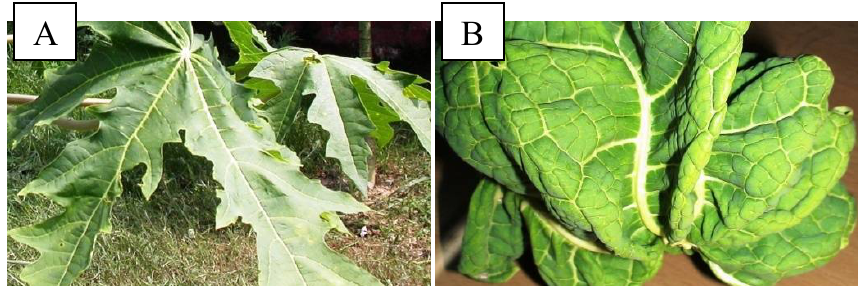
Figure 1. Morphology of ( A ) healthy and ( B ) PaLCuV-infected leaf.